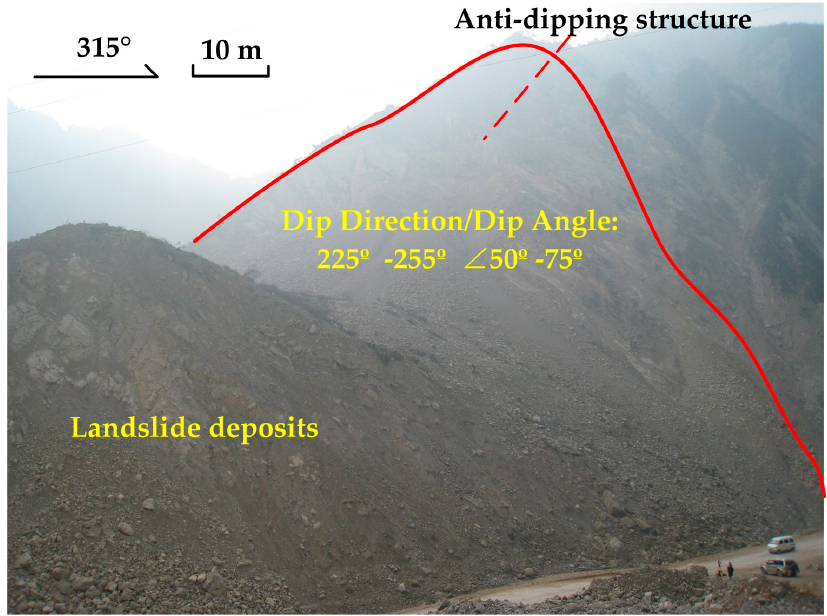
Figure 1. XiaoJianping landslide induced by Wenchuan earthquake on 12 May 2008.